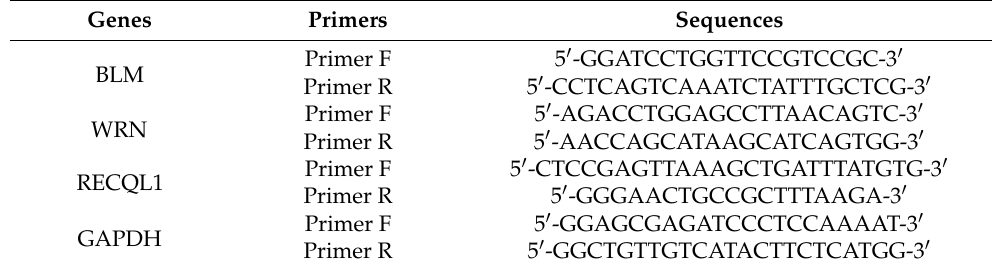
Table 3. List of primer